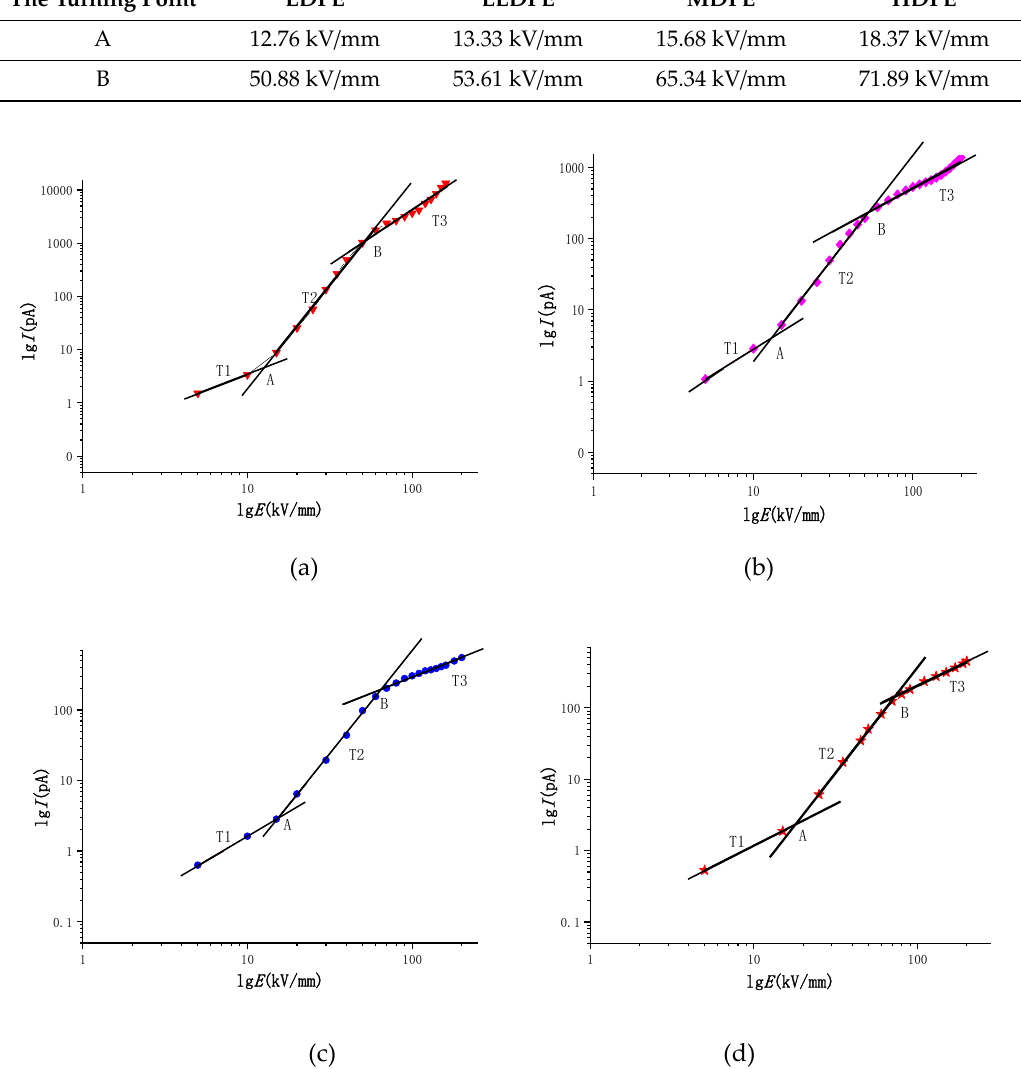
Figure 7. Logarithmic form fitting diagram of electrical conductivity flow of four different density polyethylenes: ( a ) LDPE lgI-lgE; ( b ) LLDPE lgI-lgE; ( c ) MDPE lgI-lgE; ( d ) HDPE lgI-lgE. Table 3. The slope of the line in different areas of different materials.